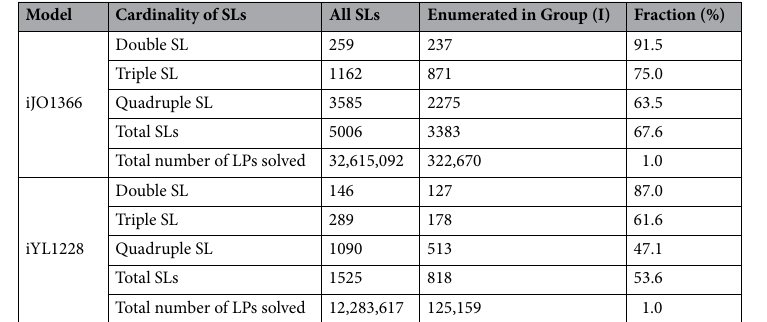
Table 3. SLs identified by evaluation of only the branches with one reaction in the starting node (Group I).